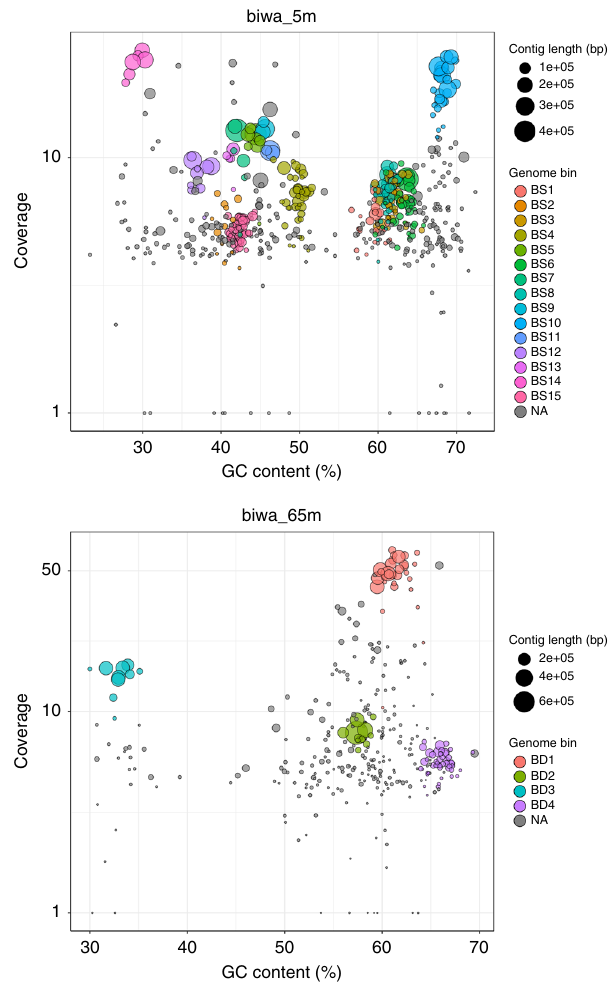
Fig. 2 Genome binning of the assembled contigs. Each circle represents a contig, where the color and size represent its assigned bin and total sequence length, respectively. Contigs not assigned to any bin are indicated in gray (named ‘ NA ’ ). The x -axis and y -axis represent GC% and genome coverage,